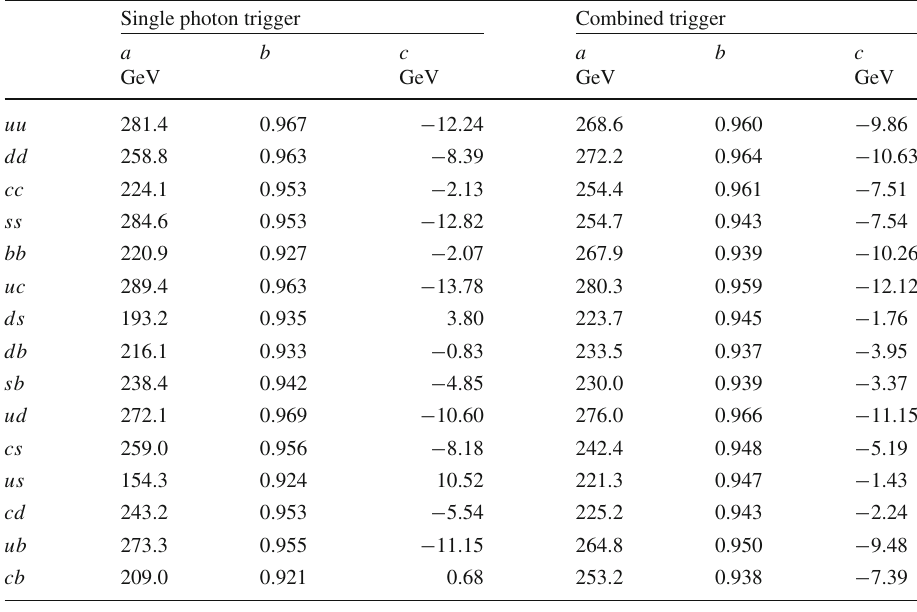
Table 10 Fit coefficients of the mass transformation function Eq. (11) in the two trigger categories (left/right) for neutral (top) and charged (bottom) particles and the different final state